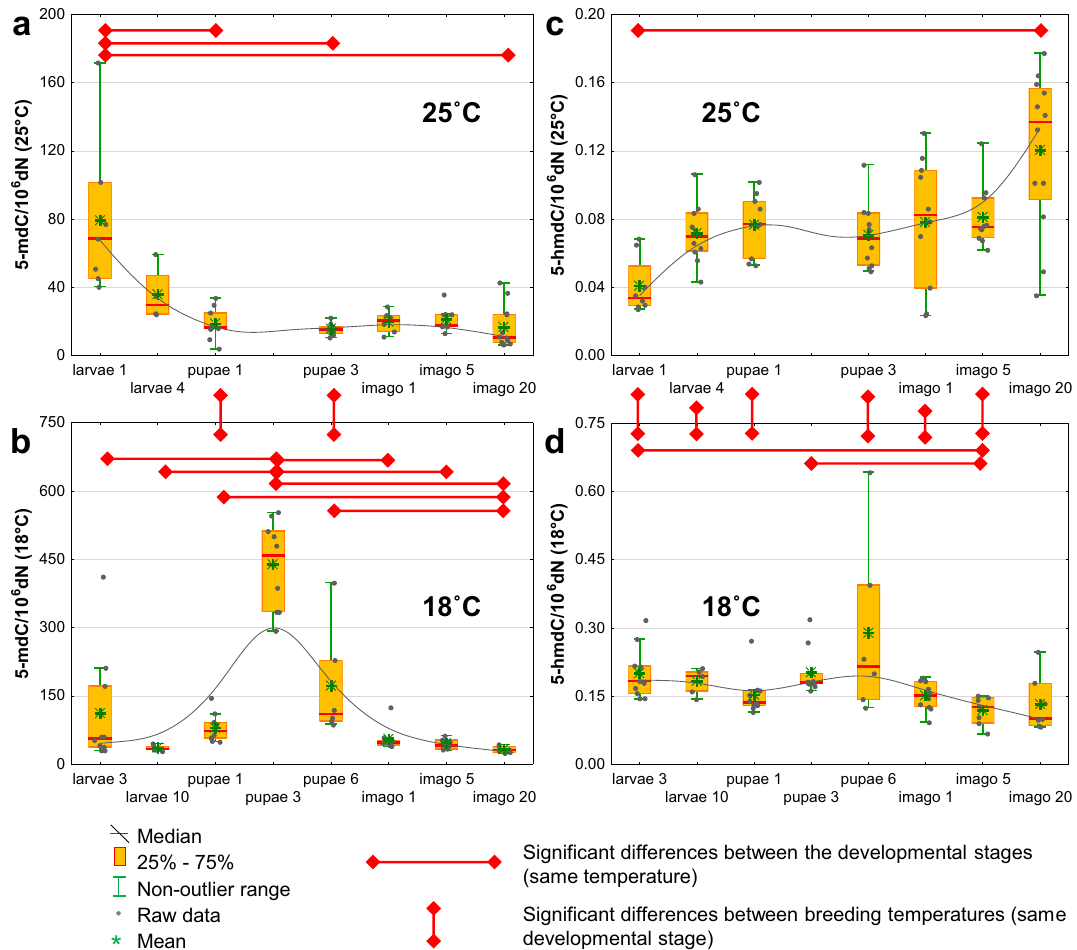
Figure 1. Changes in the levels of 5-methyl-2 ′ -deoxycytidine (5-mdC) and 5-(hydroxymethyl)-2 ′ - deoxycytidine (5-hmdC) during the D. melanogaster life cycle, ( a ) 5-methyl-2 ′ -deoxycytidine in insects bred in the optimal temperature conditions (25 °C), ( b ) 5-methyl-2 ′ -deoxycytidine in insects bred at 18 °C, ( c ) 5-(hydroxymethyl)-2 ′ -deoxycytidine in insects bred in optimal temperature conditions (25 °C), ( d ) 5-(hydroxymethyl)-2 ′ -deoxycytidine in insects bred at 18 °C. The results are presented as the mean and median values, interquartile ranges, and nonoutlier ranges ( p <